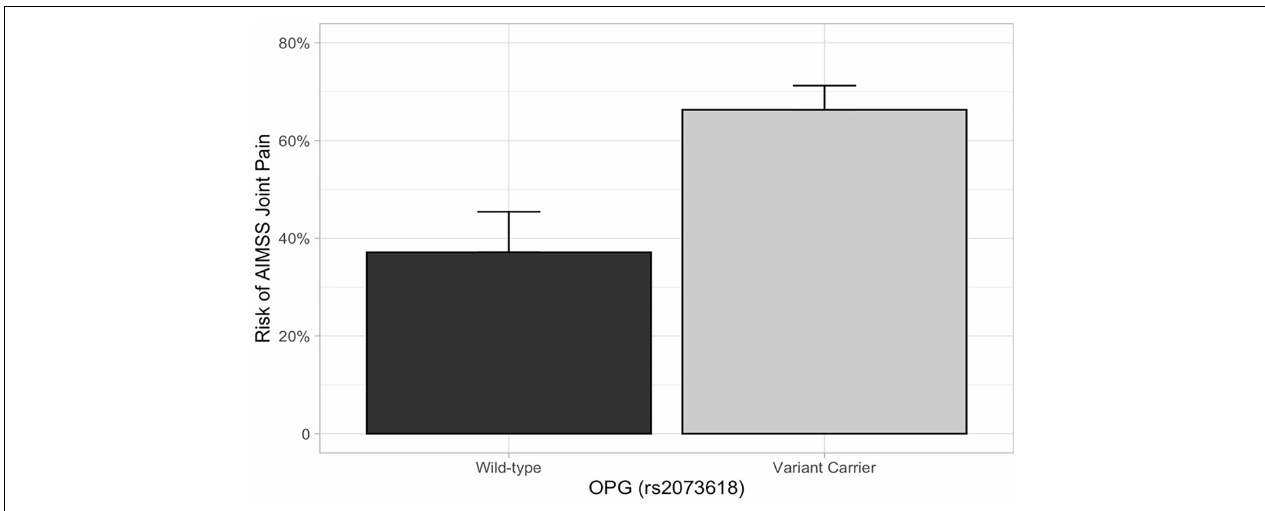
FIGURE 3 | AIMSS risk stratified by OPG rs2073618. The proportion of patients who experienced AIMSS ( Y -axis), as defined by a ≥ 1 point increase in FACT-ES from baseline to 3 or 6 months, is indicated by the box (standard error indicated by the vertical line). In the secondary analysis, patients carrying OPG rs2073618 ( n = 102) had a greater risk of AIMSS, defined by the increase in joint pain measured by the FACT-ES (unadjusted OR = 3.33, 95% CI: 1.48–7.49, p = 0.004).